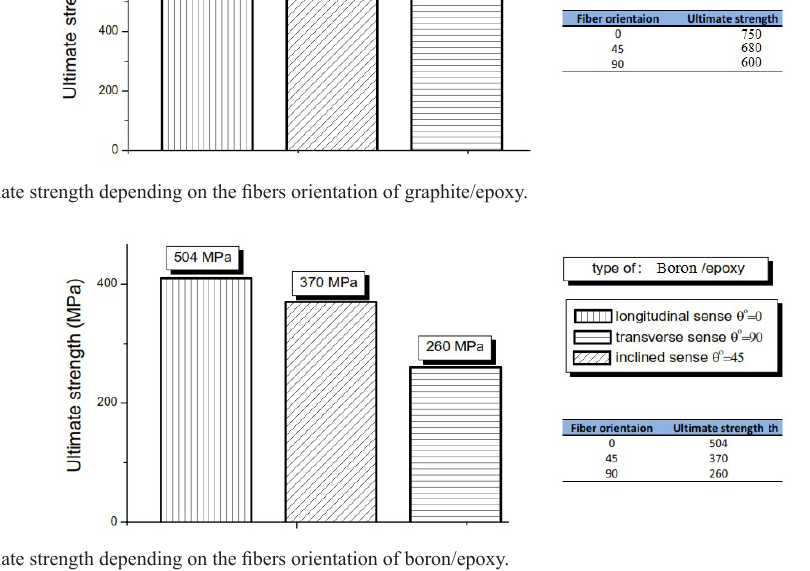
Figure 5. Ultimate strength depending on the fibers orientation of boron/epoxy.